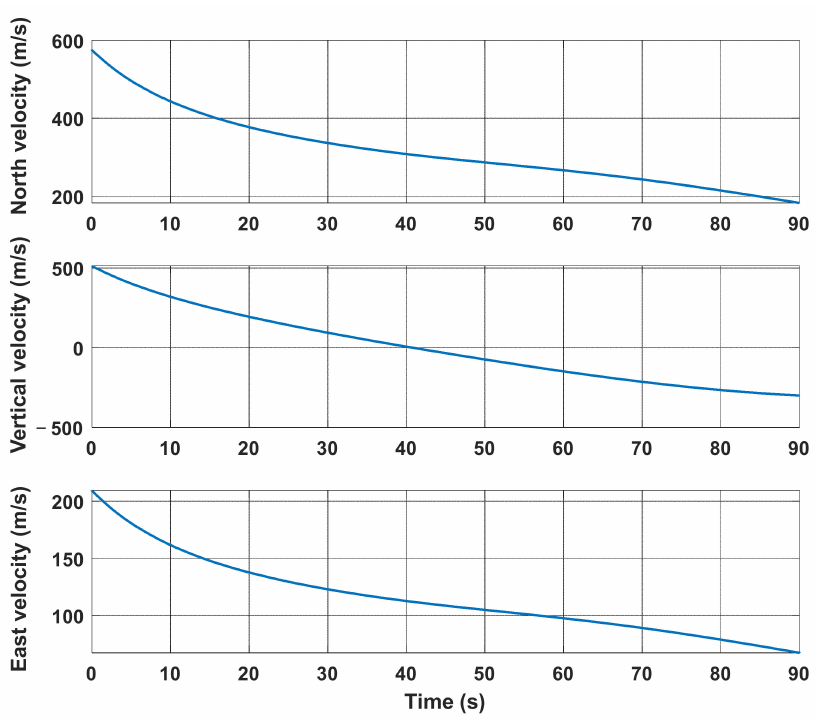
Figure 7. Three‑dimensional velocity of projectile.